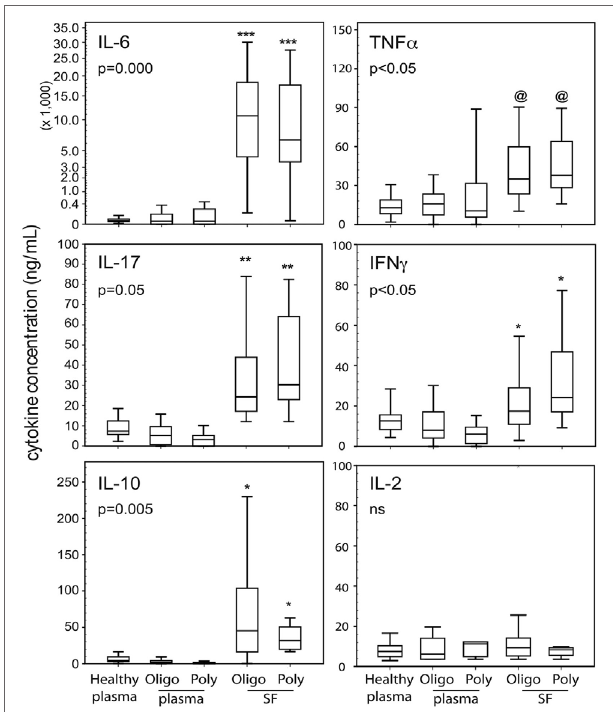
FigUre 1 | Cytokine profiles in blood and cell-free SF of JIA patients. Data shown ( n = 15–39 per group as in Table 1 ) are box-median-whisker plots of the five most dominant cytokines found in SF compared to plasma. The boxes represent the 25th and 75th percentile of values. The whiskers were the 5th and 95th percentile of values. There was not a global cytokine upregulation as shown by negligible detection of IL-2. The indicated P -values were determined by Kruskal–Wallis ANOVA. Between group comparisons were made using the post hoc Tukey statistic: [***], [**], and [*] P < 0.005, P < 0.01, and P < 0.05, respectively, indicate JIA SF is significantly different from healthy and JIA plasma; [@] indicates polyarticular [poly]/oligoarticular [oligo] SF were not significantly different from poly JIA plasma, but were significantly different ( P < 0.05) from oligo JIA and healthy plasma. Abbreviation: NS, not